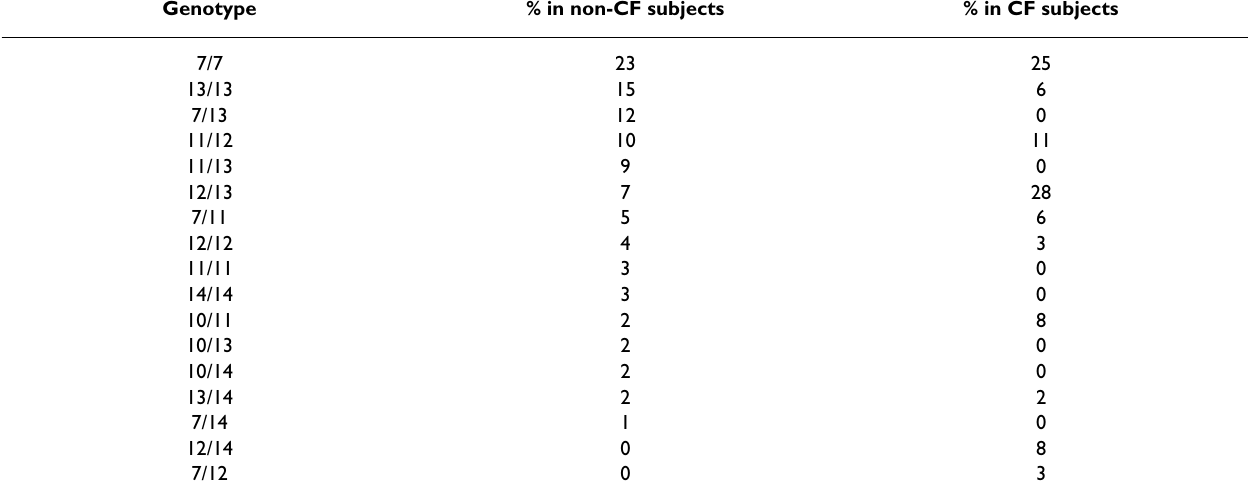
Table 2: Genotypes frequencies of the MRP1 (GCC)n alleles in the control group and in the CF patients